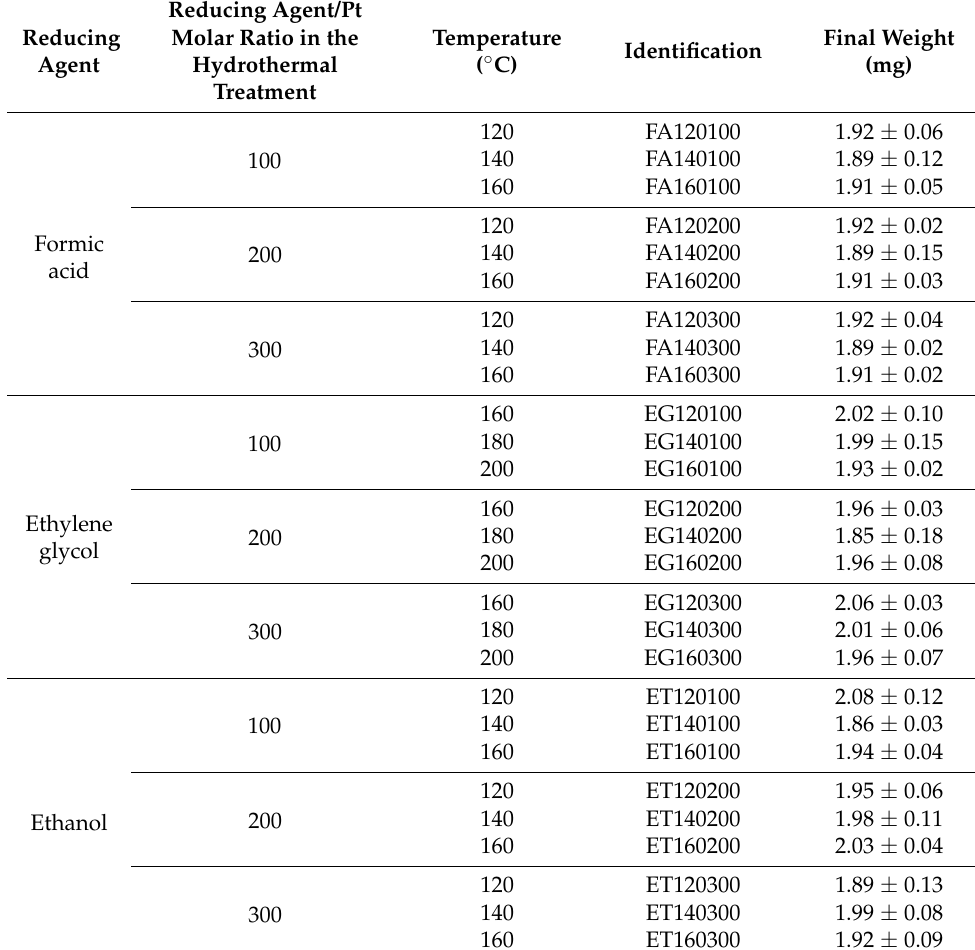
Table 1. Final weight of the thermally treated Pt@GDL to estimate the Pt loading (expected value of 2